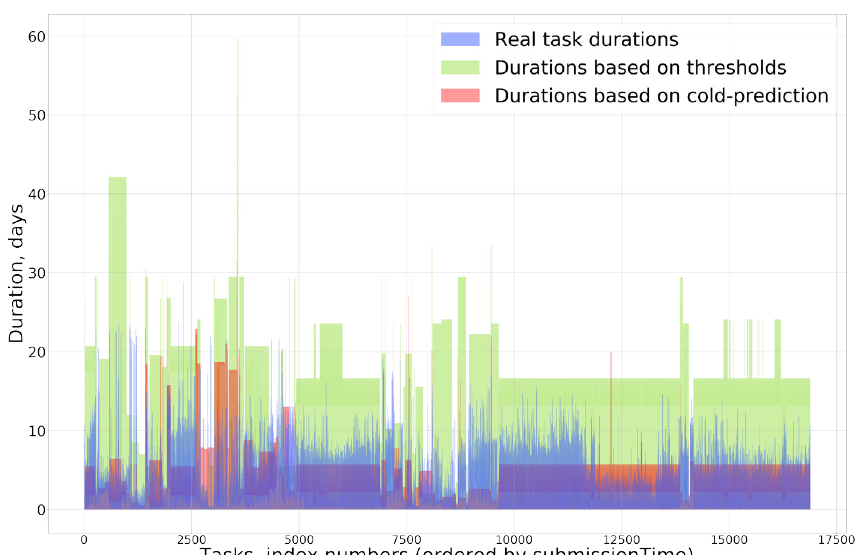
Figure 3. Real and estimated durations of ATLAS tasks execution (group of tasks for 2 weeks, 16,880 tasks): blue color - real duration for every task in the range, green color - estimated duration based on threshold definition per task type for every task in the range, red color - estimated duration based on prediction generation of “cold” type for every task in the range